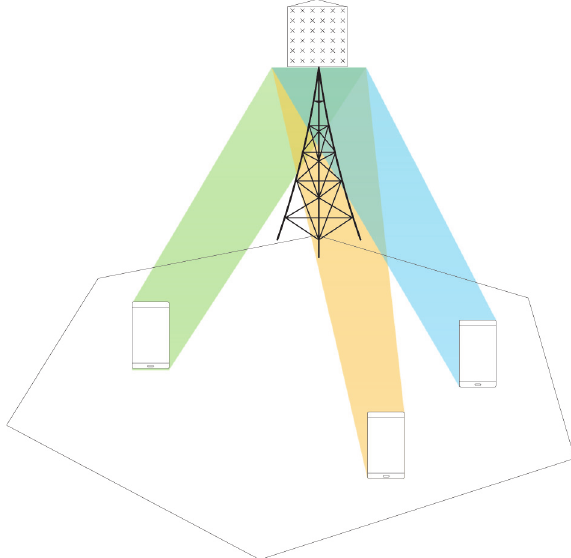
Figure 1: A MU-MIMO system with a large-scale antenna